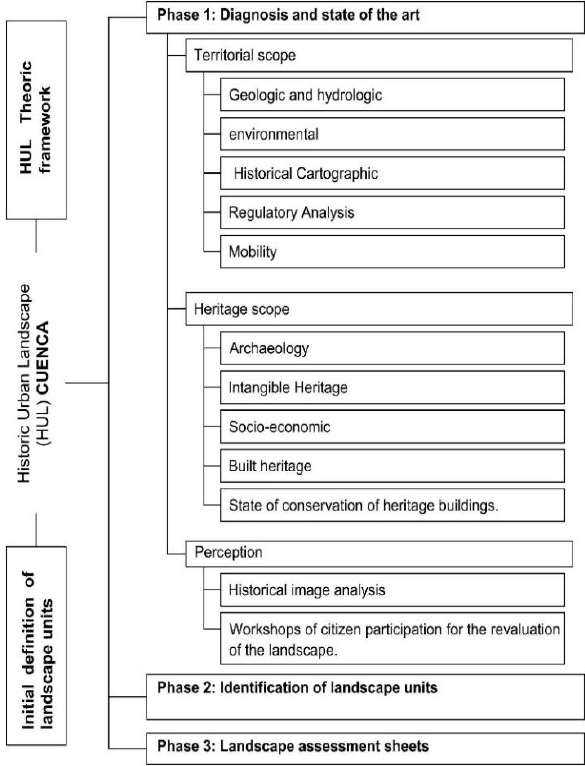
Figure 2. Methodology base, Source: